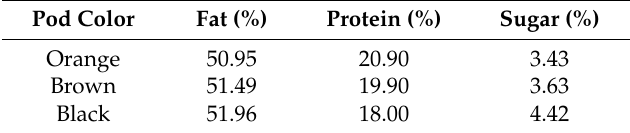
Table 1. Macronutrient Composition of Arachis hypogaea Seeds of Different Maturation Classes. Pod Color Fat (%) Protein (%) Sugar (%) Orange 50.95 20.90